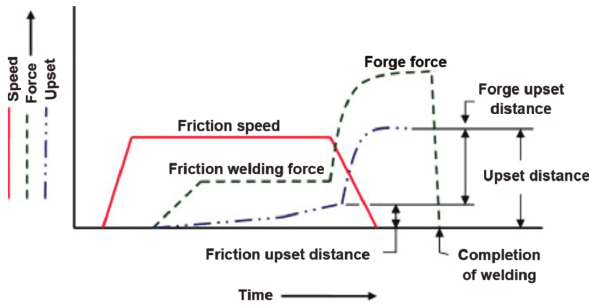
Figure 2: Parameters of continuous drive friction welding.